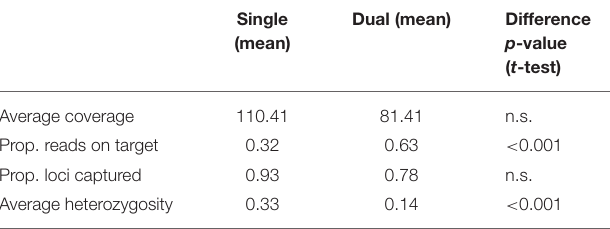
TABLE 1 | Sequencing success of single- vs. dual-indexed rodent samples.